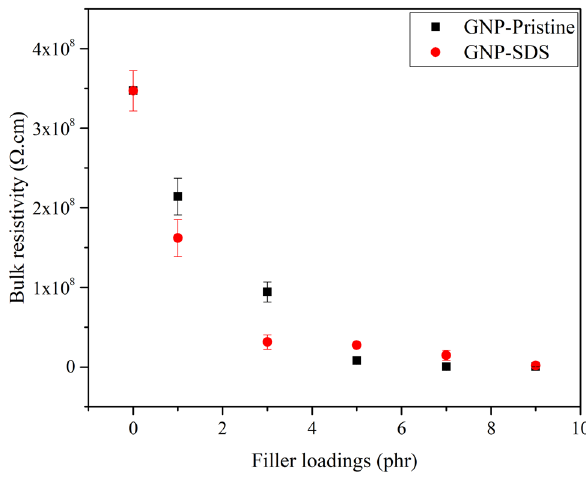
Figure 8: Bulk resistivity of NRL/GNP - pristine and NRL/GNP – SDS with various loadings.